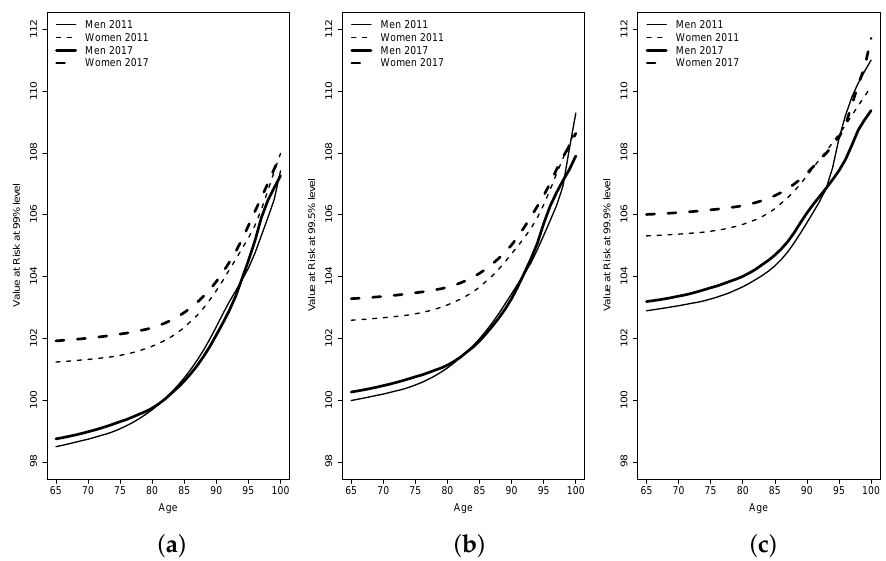
Figure 2. CQ p of year 2011 (thin lines) and 2017 (thick lines) of the age-at-death variable estimated a from Beta Transformed Kernel Estimator (BTKE), ( a ) p a = 0.99, ( b ) p a = 0.995 and ( c ) p a = 0.999.